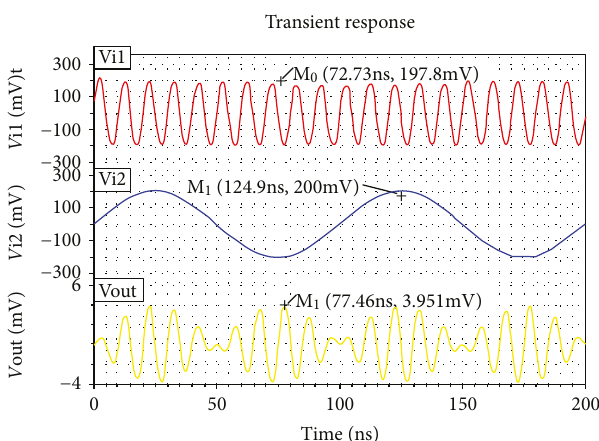
Figure 2: The amplitude and phase frequency of the OA.